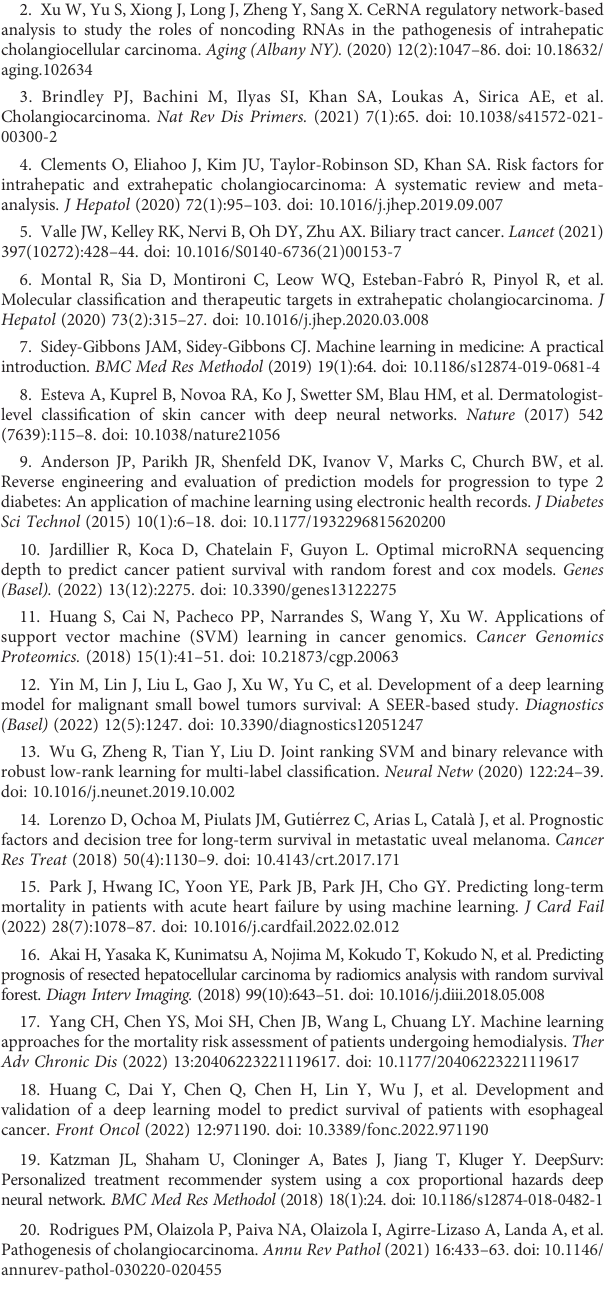
SUPPLEMENTARY FIGURE 4 The time-dependent ROC analysis in TNM Classi fi cation. The time- dependent ROC analysis in TNM Classi fi cation and the DeepSurv algorithm had the highest mean AUC. SUPPLEMENTARY FIGURE 5 The Kaplan – Meier analysis and log-rank test in different risk group according to DeepSurv model. (A) The DeepSurv risk strati fi cation of patients in the training cohort. (B) The DeepSurv risk strati fi cation of patients in the validation